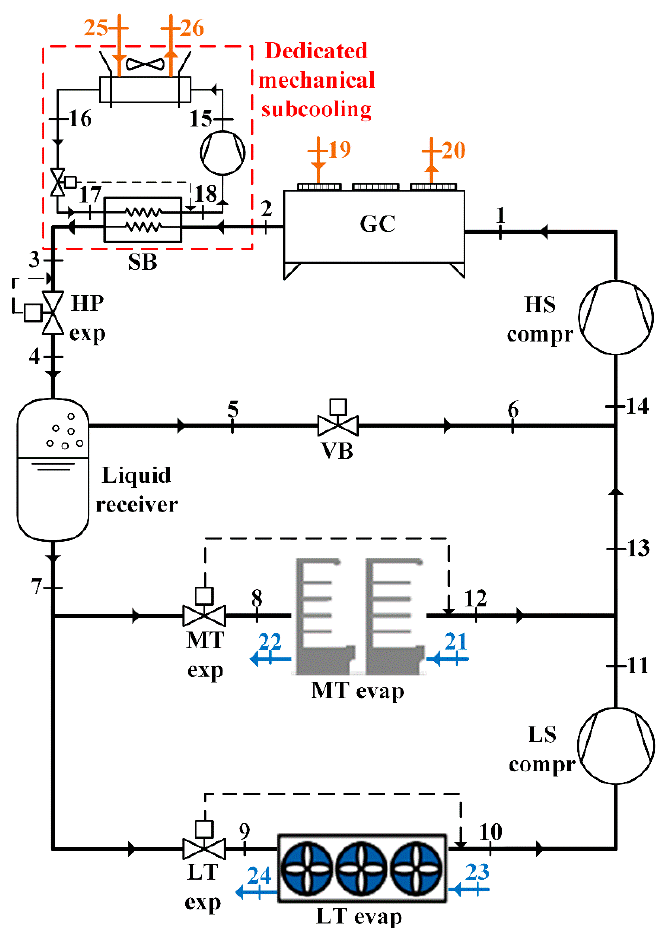
Figure 1. Schematic of an R744 booster refrigeration system with dedicated mechanical subcooling (DMS).